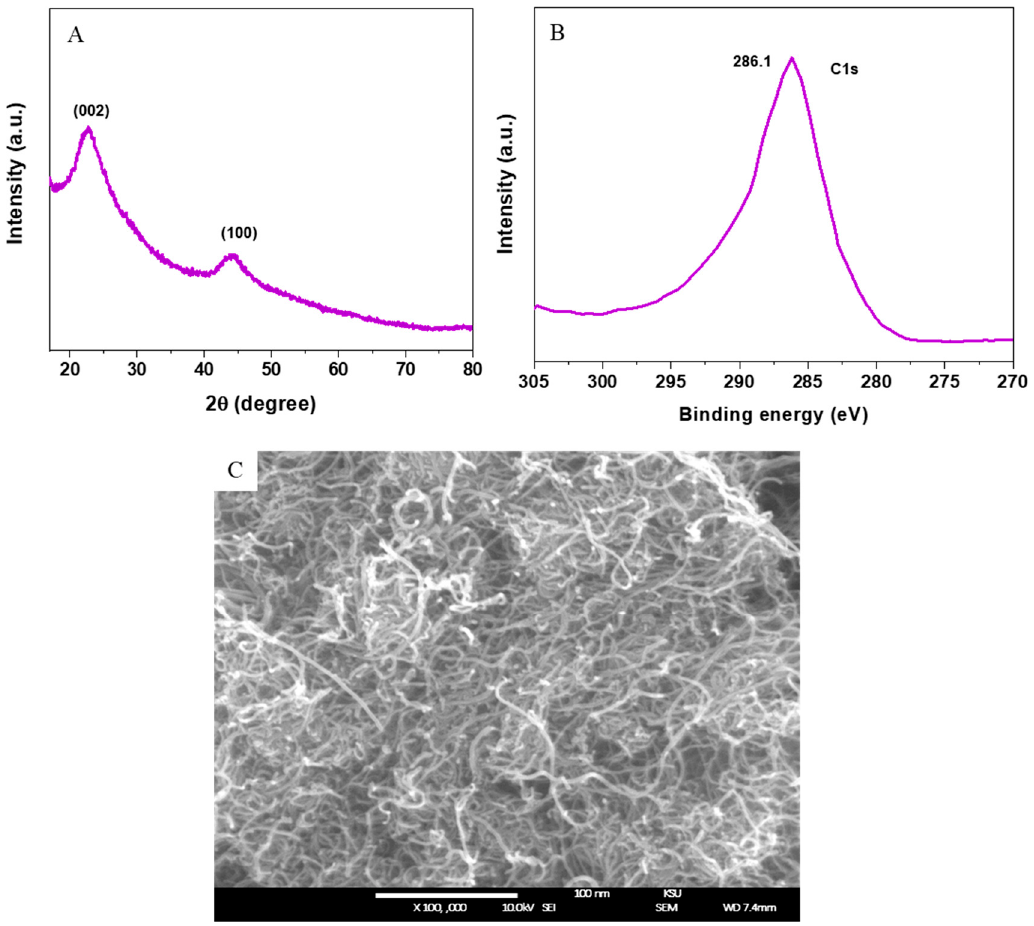
Figure 1. Characterization of single-walled carbon nanotubes (SWCNTs). ( A ) XRD spectra, ( B ) C1s of XPS, and ( C ) FESEM image. SWCNTs: Single-walled carbon nanotubes, XRD: X-ray diffraction, XPS: X-ray photoelectron spectroscopy, FESEM: Field emission electron microscopy.